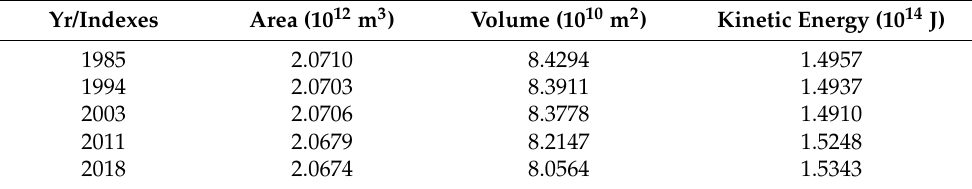
Table 4. The sea surface area, volume, and kinetic energy of the BHS in different periods.